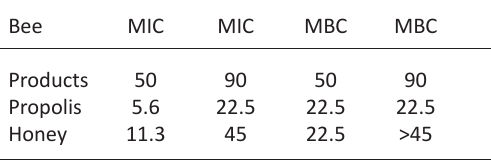
Table 5. Result of the MIC50 MIC 90, MBC 50, and MBC 90 of Propolis and honey for the studied isolates Bee MIC MIC MBC Products